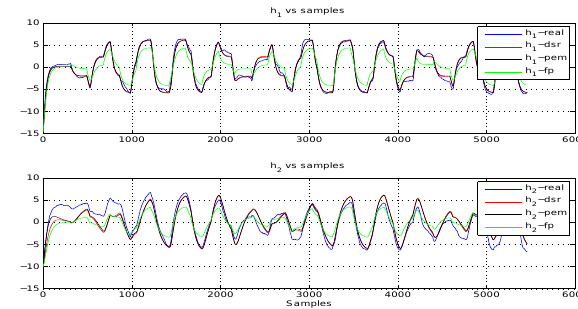
Figure 5: This figure illustrates the real measurements of the level in the two lower tanks as well as the corresponding simulated outputs of the system identification models, from DSR and PEM, as well as the simulated outputs from the first principles